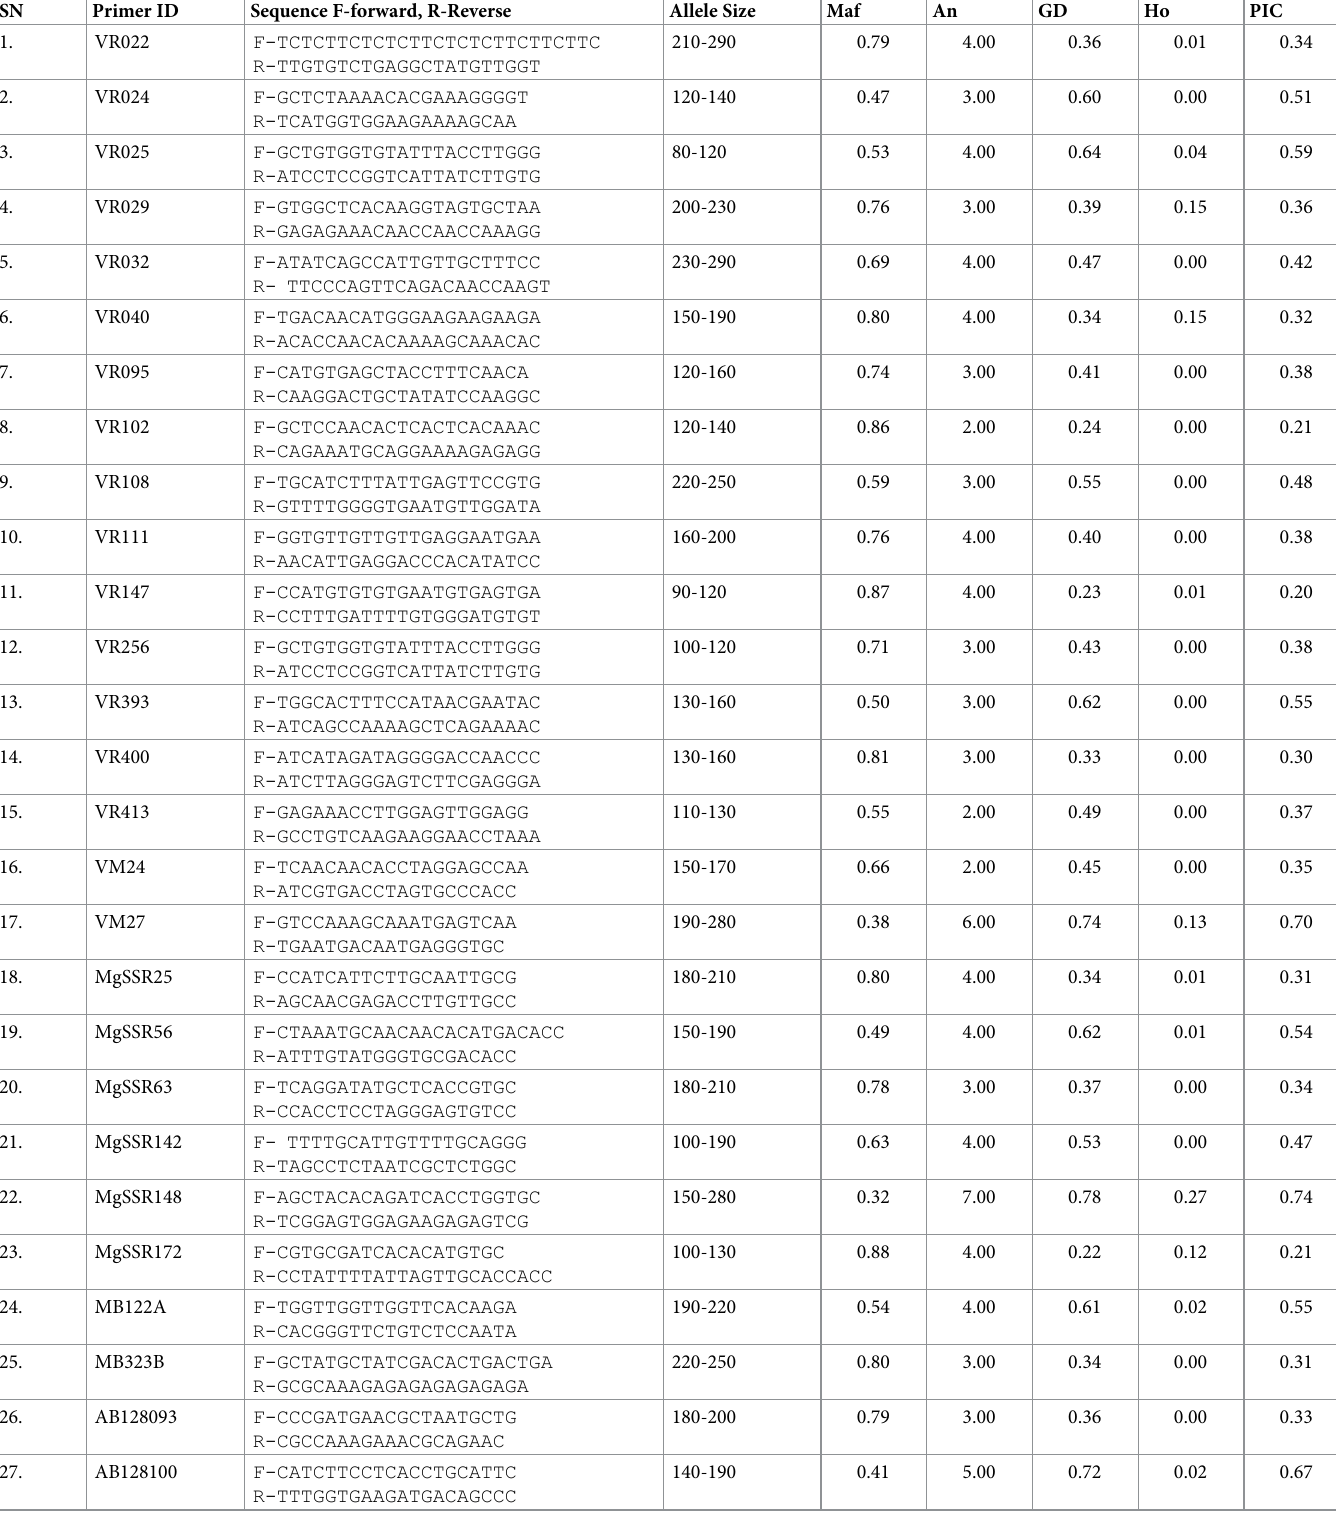
Table 5. Genetic variability indices of the SSRs among the set of V . stipulacea accessions.